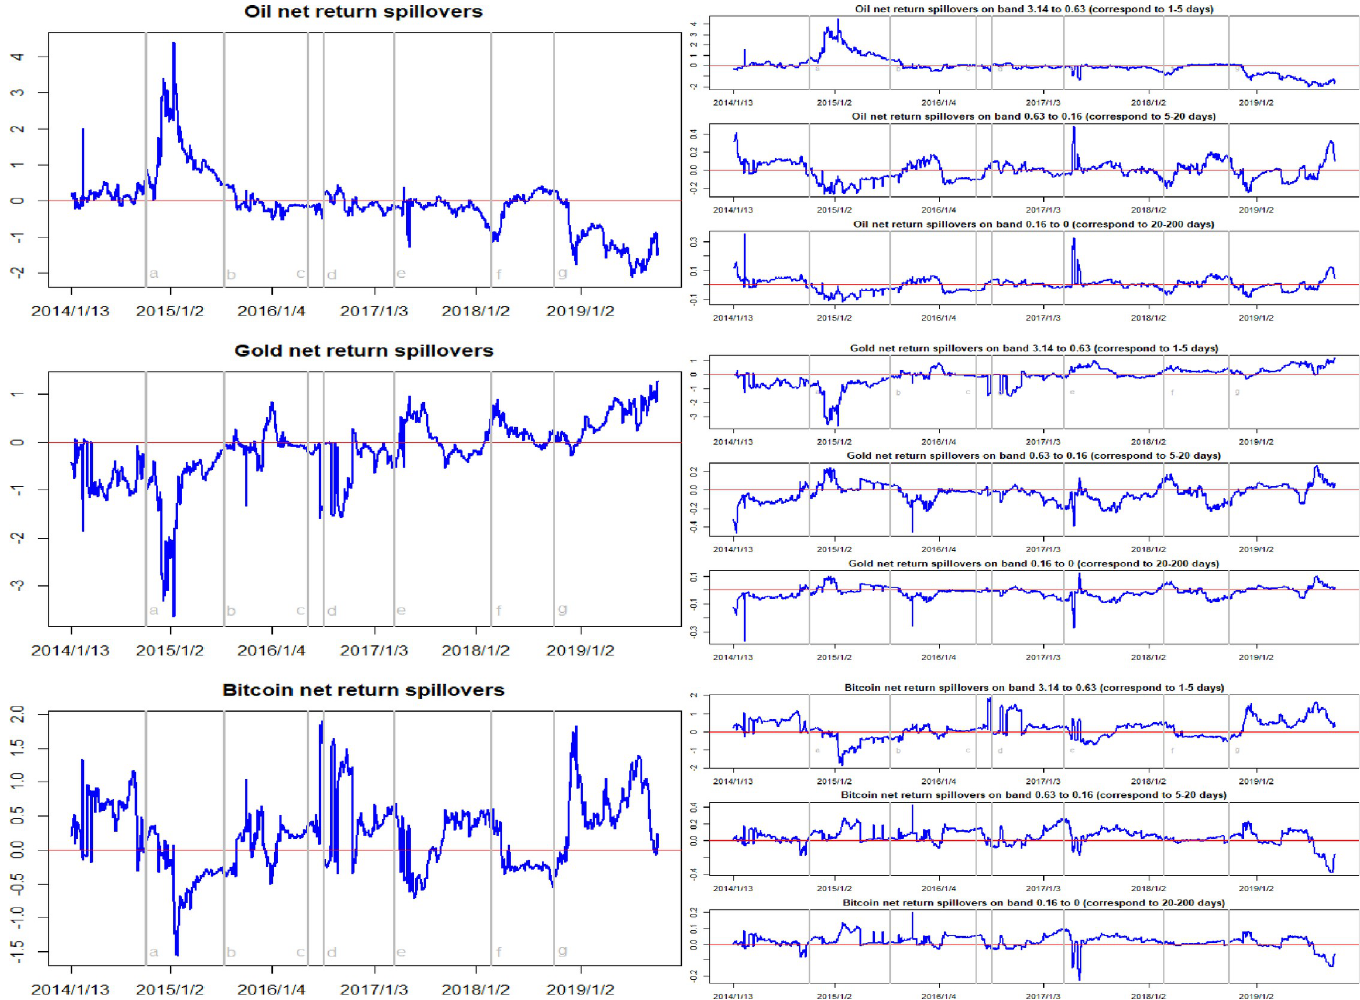
Fig 7. Time-frequency dynamics of net return spillovers for oil, gold, and Bitcoin. a, b, c, d, e, f, g respectively represent the seven events: the WTI oil price collapsed in October 2014, the black swan event in gold market occurred in July 2015, the sharp rise of bitcoin prices in May 2016, the Brexit event in July 2016, the expectations of a Federal Reserve rate hike in March 2017, the price of Bitcoin and gold fluctuating fall at the beginning of 2018, and the WTI oil price declines in August